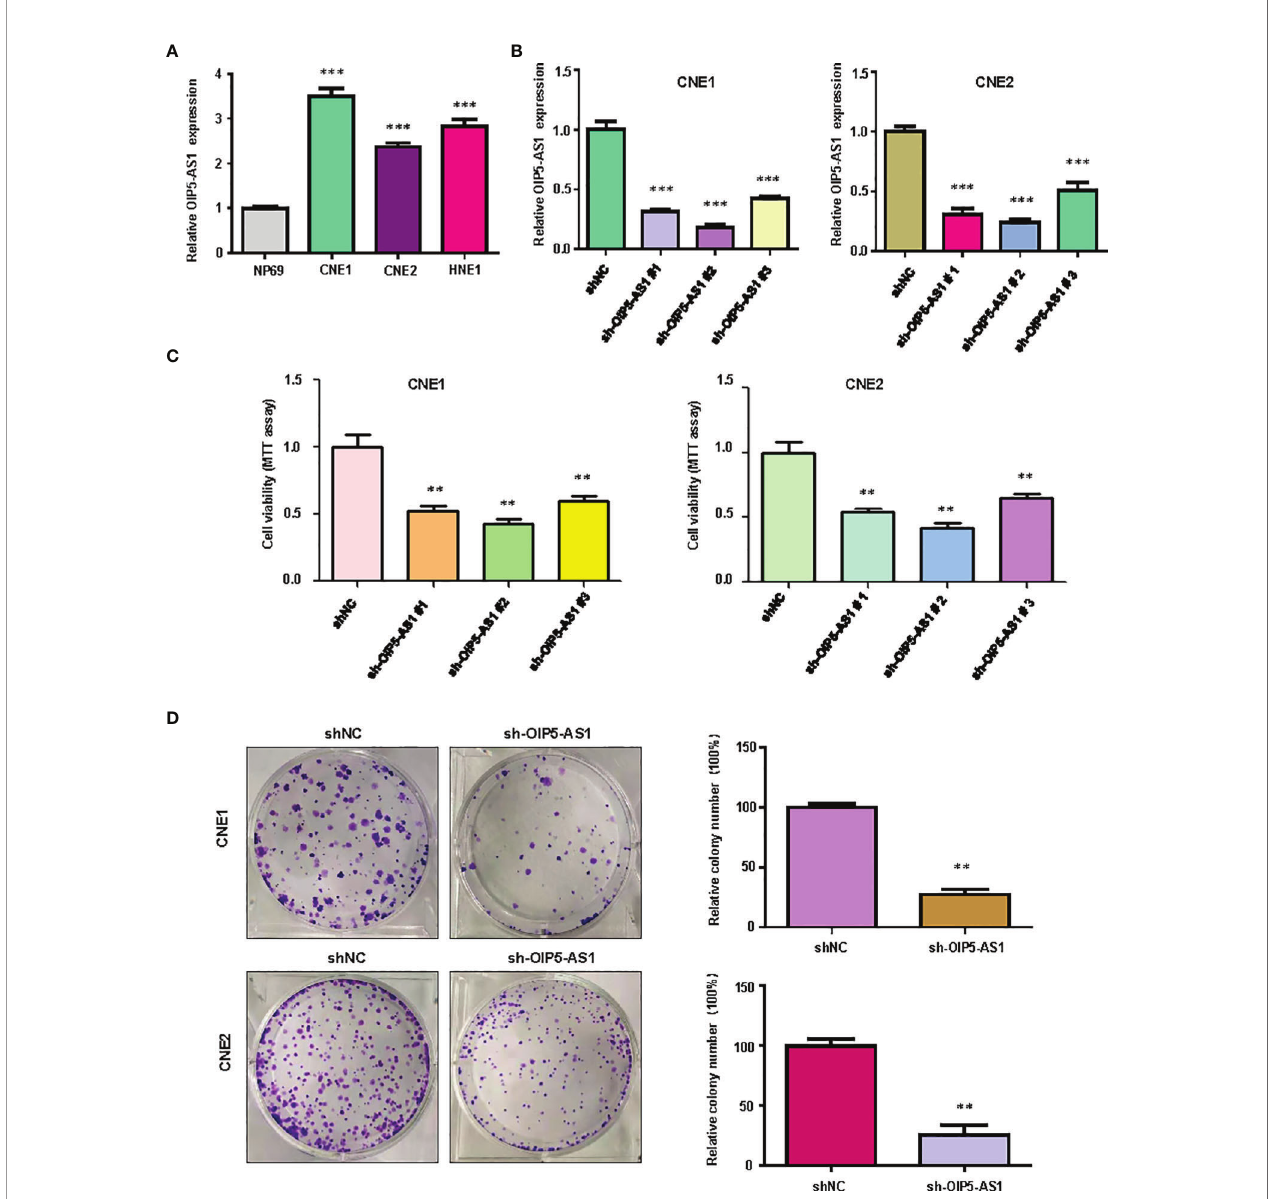
FIGURE 1 | Knockdown of OIP5-AS1 inhibits viability of NPC cells. (A), RT-PCR assay was used to measure the expression of OIP5-AS1 in several NPC cell lines. ***P<0.001 vs control. (B), RT-PCR was used to detect the ef fi cacy of OIP5-AS1 knockdown in CNE1 and CNE2 cells. ***P<0.001 vs control. (C), MTT assay was used to measure the viability of NPC cells after OIP5-AS1 knockdown. **P<0.01 vs control. (D), Cell colony formation was performed in NPC cells after OIP5-AS1 knockdown (Left panel). Quantitative data are represented (Right panel). **P<0.01 vs